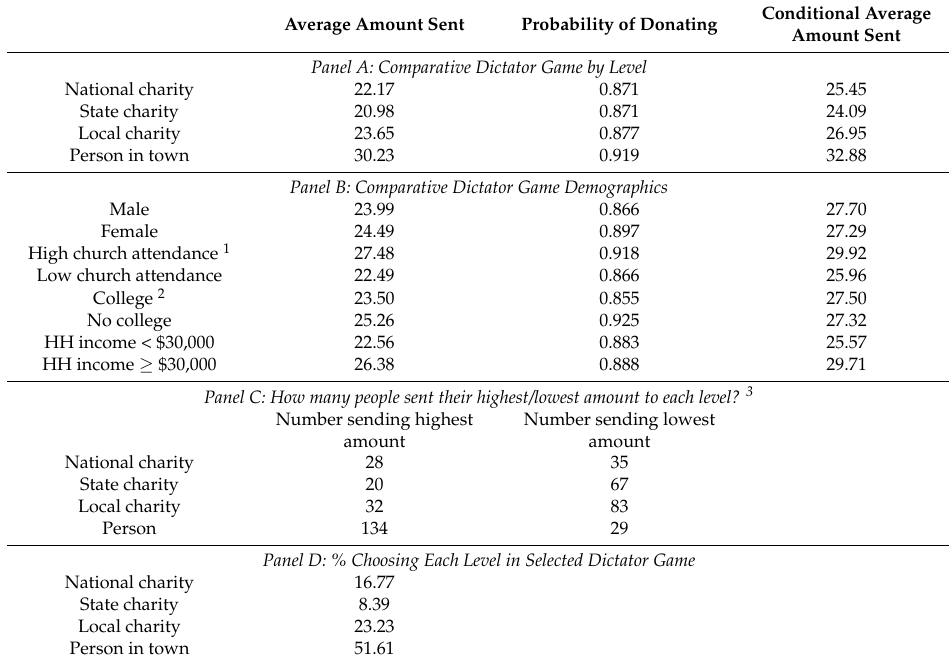
Table A1. Summary of dictator game decisions ( n = 310). Average Amount Sent